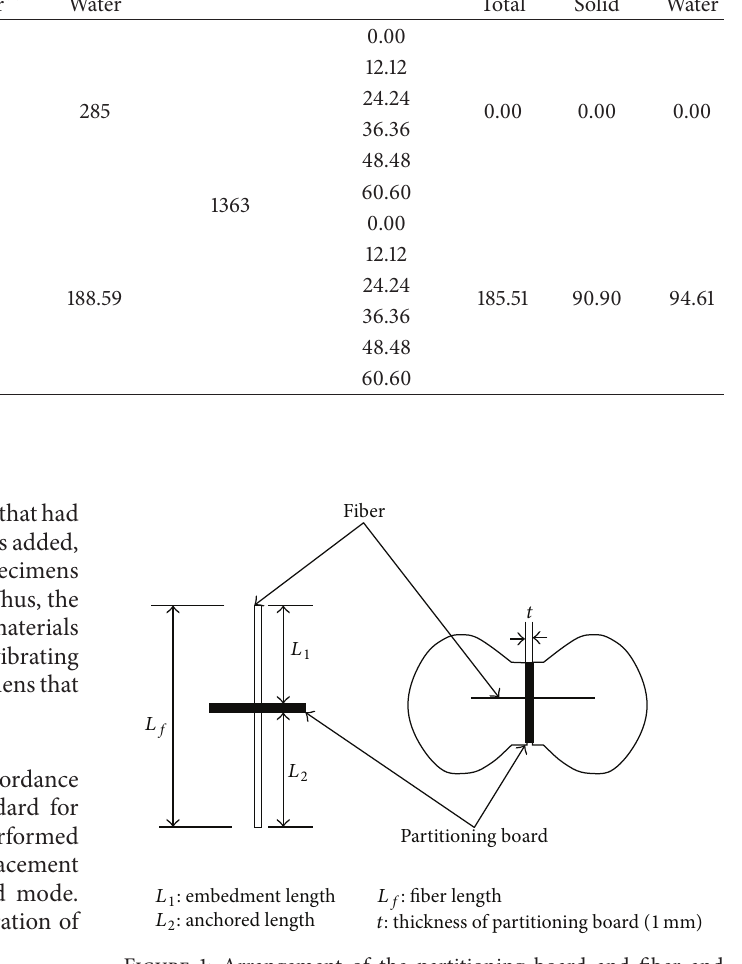
Figure 1: Arrangement of the partitioning board and fiber and setting in the